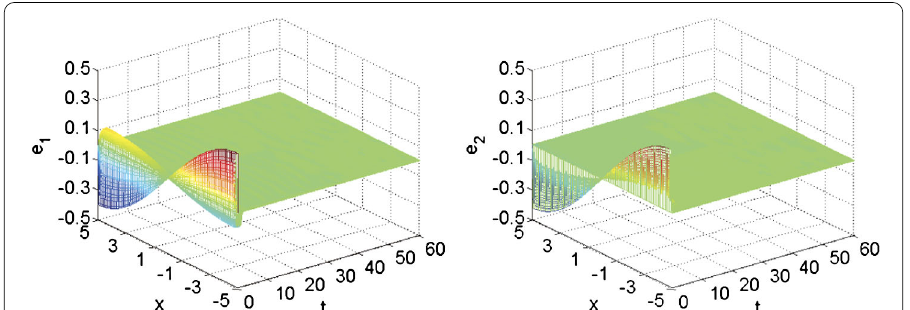
Figure 2 Asymptotic behaviors of the synchronization